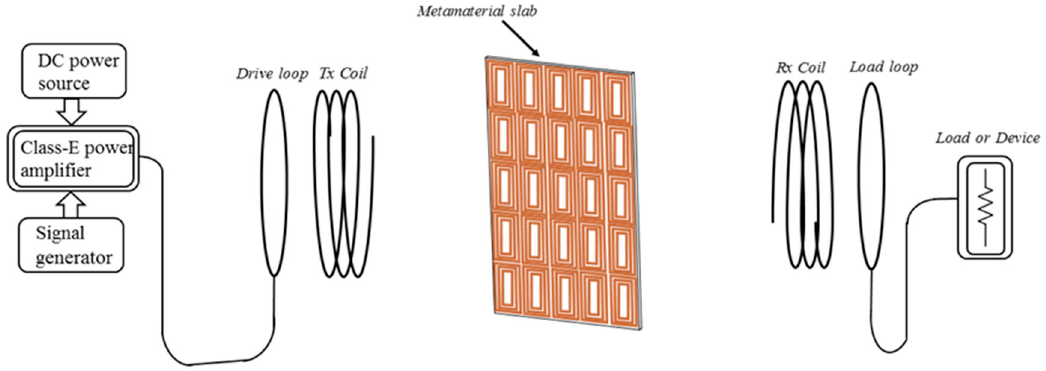
Figure 1. The architecture of the Wireless Power Transfer (WPT) system based on the metamaterials (MMs).